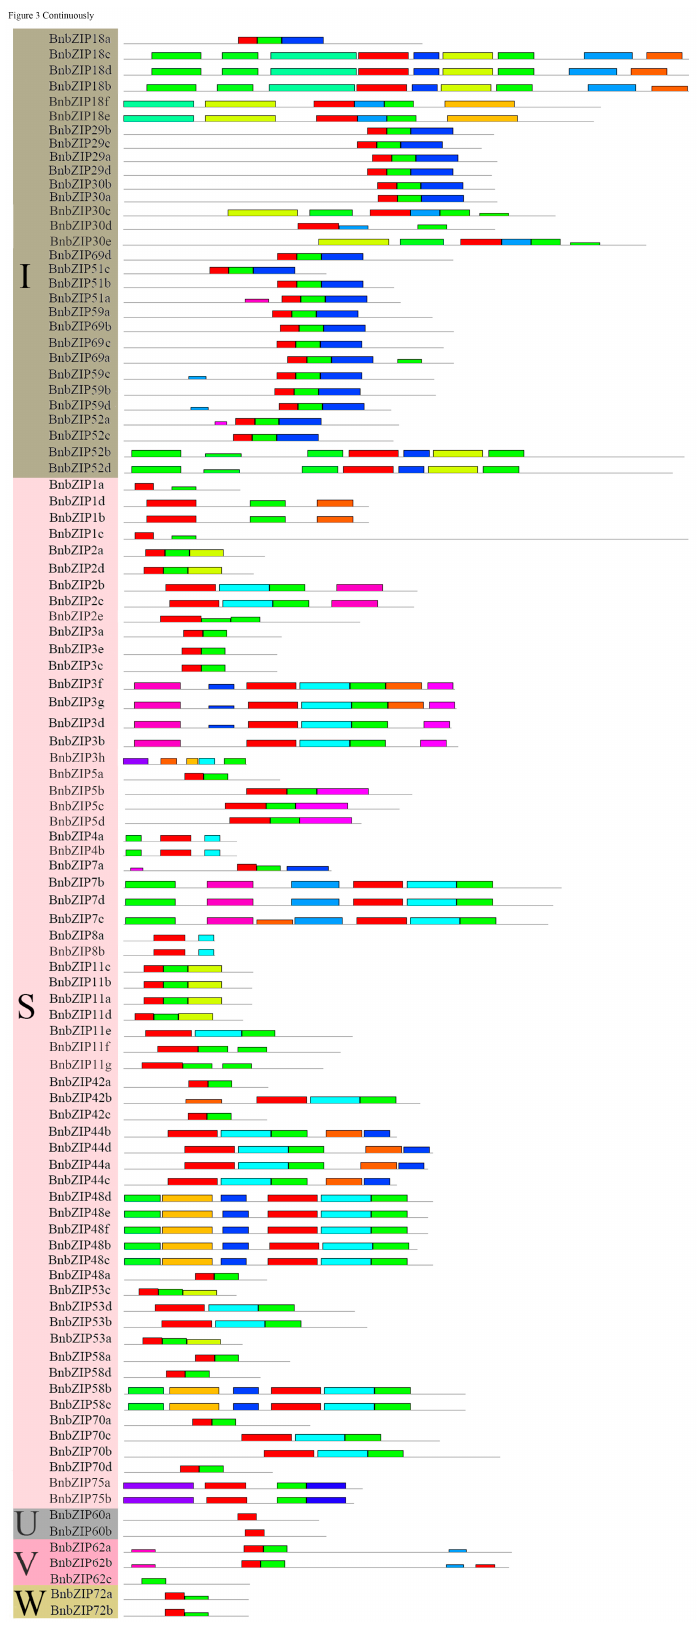
Figure 3. Motif patterns and WebLogo plots of the different BnbZIP subfamilies. The 247 B. napus BnbZIP amino acid sequences were aligned (Figure S1). The motifs are indicated by different colored boxes (numbered Motif 1–15).